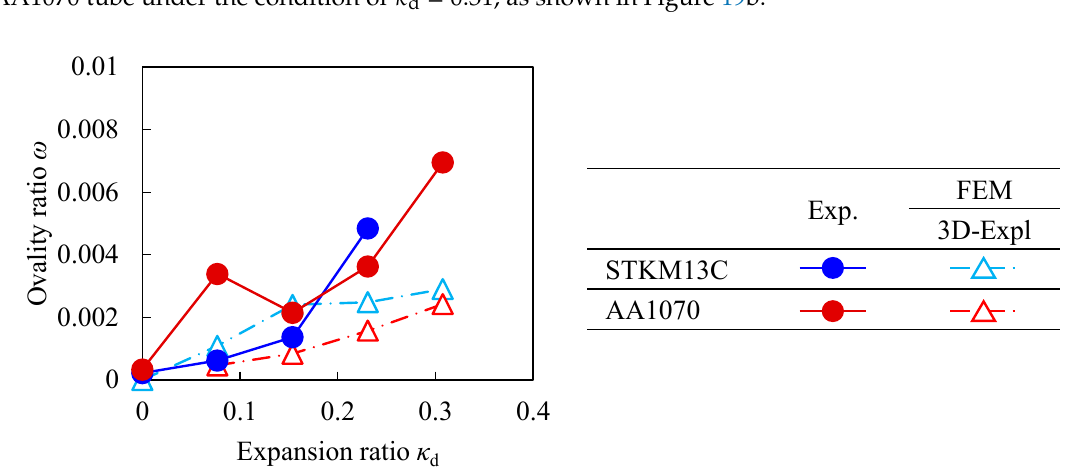
Figure 17. E ff ect of expansion ratio κ d on ovality ratio ω Figure 17. Effect of expansion ratio κ d on ovality ratio ω .